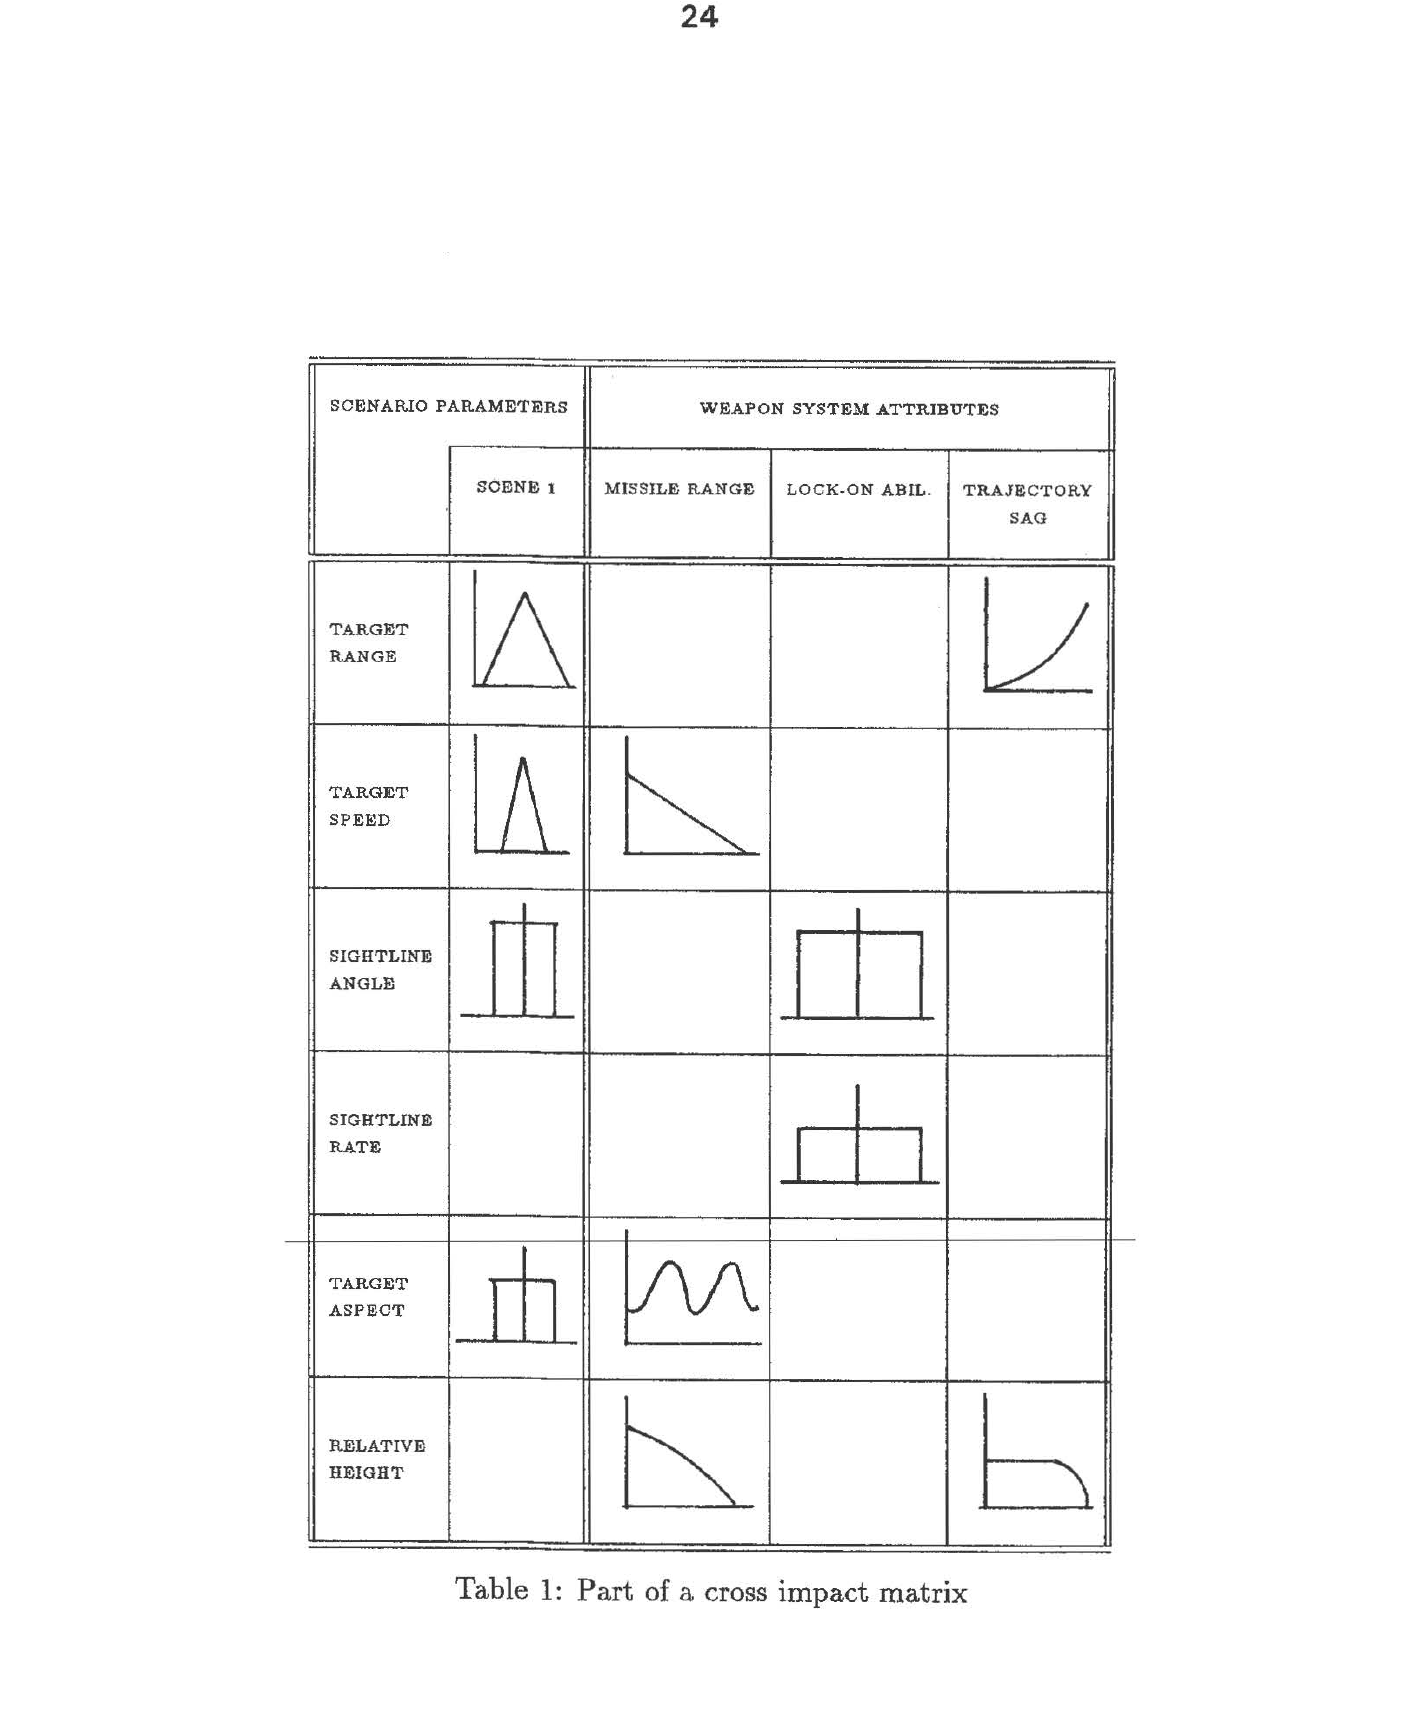
Table 1: Part of a. cross impact